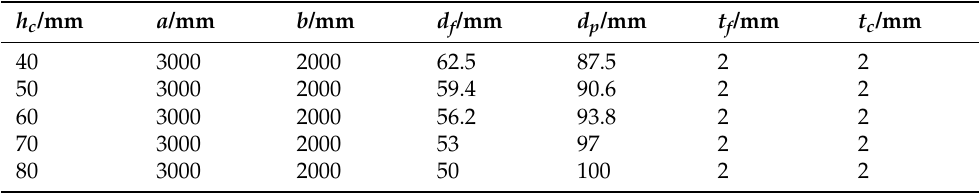
Table 7. Geometric parameters of the U-type corrugated sandwich panel with different core